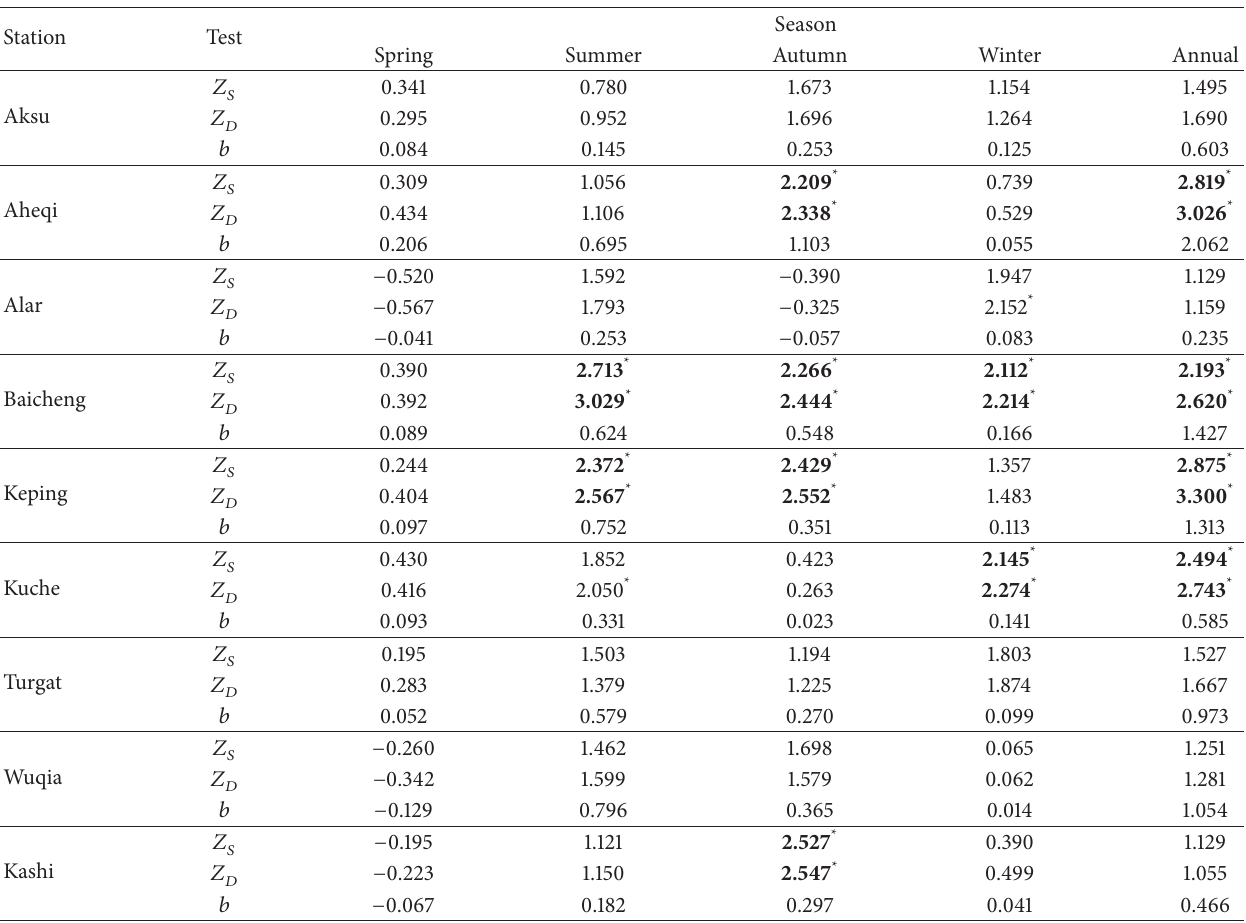
Table 7: Results of the statistical tests for seasonal and annual precipitation during the period 1960–2010.